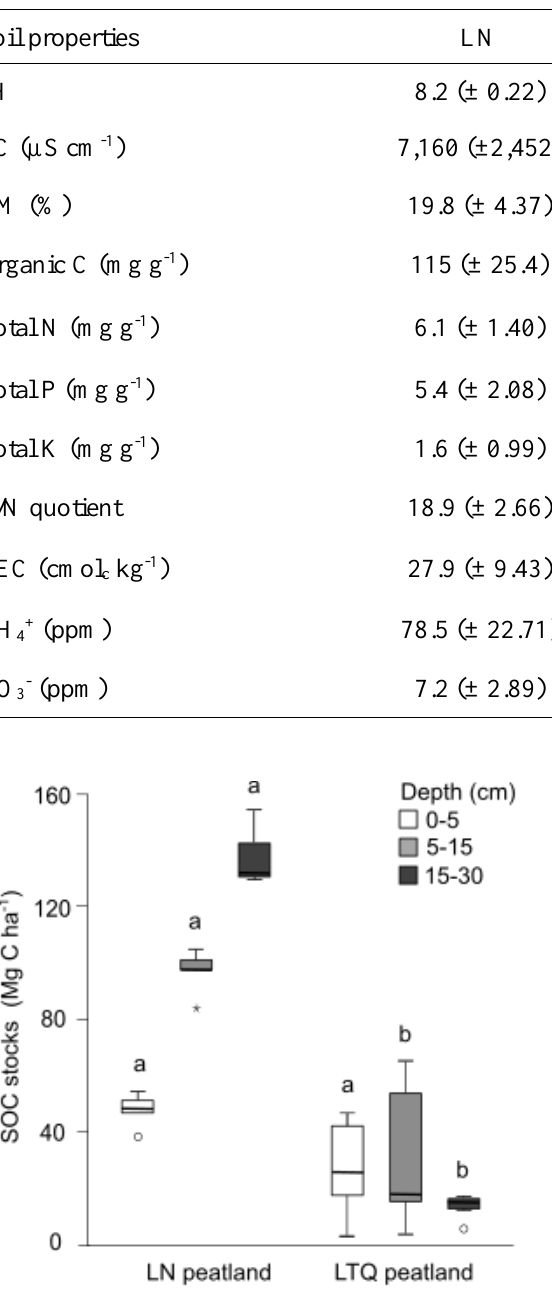
Table 1. Soil physico-chemical properties (mean value ± standard deviation, n = 5) at depth 0–15 cm in the peatlands associated with Laguna Negra (LN) and Laguna Tres Quebradas (LTQ). EC: electrical conductivity, OM: organic matter, C: carbon; CEC: cation exchange capacity. For soil properties that differ significantly (p < 0.05) between peatlands, the values of F and p are shown in bold .